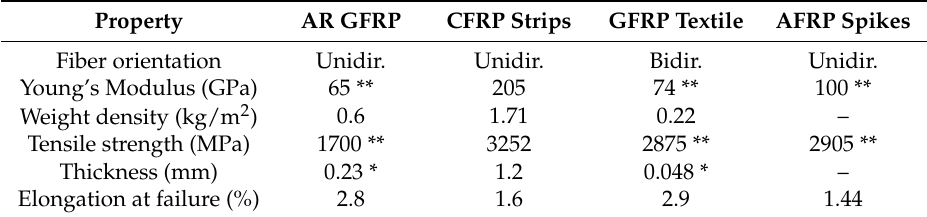
Table 1. Mechanical characteristics of fiber reinforced polymer